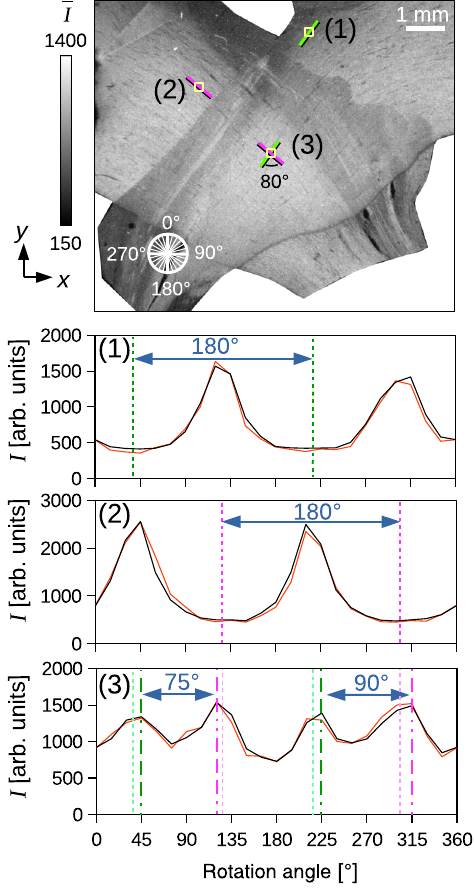
FIG. 8. Scattering measurement of two optic tracts, extracted from a 30- μ m-thin section of a human optic chiasm, placed on top of each other with a crossing angle of approximately 80°. The measurement is performed as described in Appendix A 5 with a pixel size in object space of about 6 . 5 μ m and a mask with a rectangular hole which illuminates the sample under a fixed polar angle of 49 . 1 °. During the measurement, the mask is rotated by angles of f 0 ° ; 15 ° ; … ; 345 ° g around the center of the sample (starting on top and rotating clockwise; see the compass rose on top). The upper image shows the transmitted light intensity recorded by the camera averaged over all rotation angles of the mask. For evaluation, a region of 10 × 10 pixels is selected in each of the two fiber bundles [(1) and (2)] and in the crossing region (3). The selected regions are indicated by a yellow square in the upper image, and the in-plane orientations of the nerve fibers (derived from visible tissue structures) are indicated by green and purple lines. The graphs show the average transmitted light intensity I in the three evaluated regions plotted against the rotation angle of the mask (black curves). The red curves show the transmitted light intensity of the middle pixel ( 1 × 1 pixels) in the selected regions. The dashed vertical lines indicate the orientations of the fibers as marked in the upper image. The dash-dotted lines in (3) indicate the position of the measured fibers [(1) and (2)] and one region with crossing fibers (3). The yellow squares in the upper image mark the selected regions; the green and purple lines indicate the in-plane